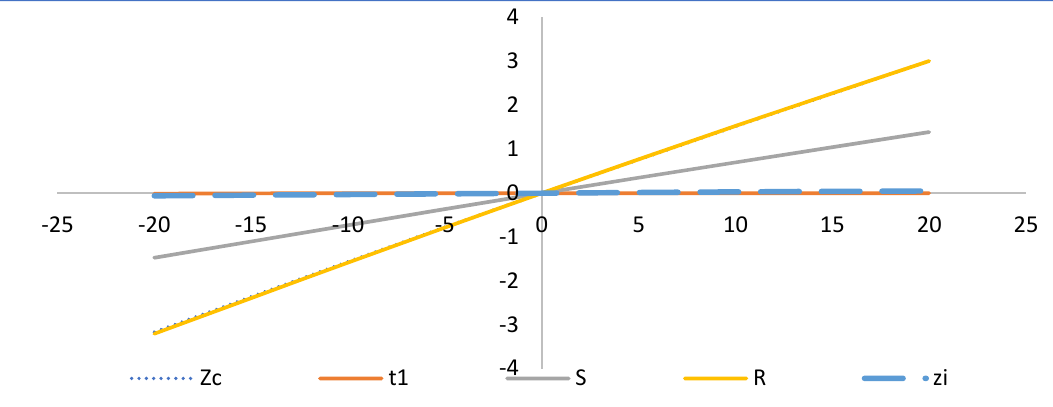
Figure 6. Impact of post optimality analysis of ‘ a ’ on C Z ,